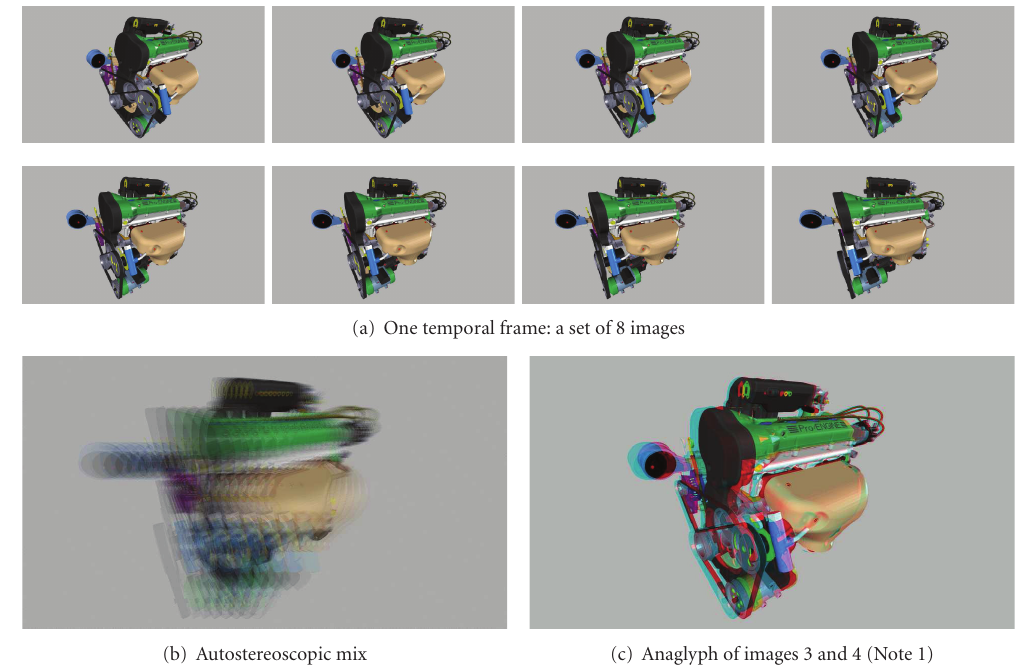
Figure 4: Images synthesis of engine photo with courtesy of PI3C, partner of